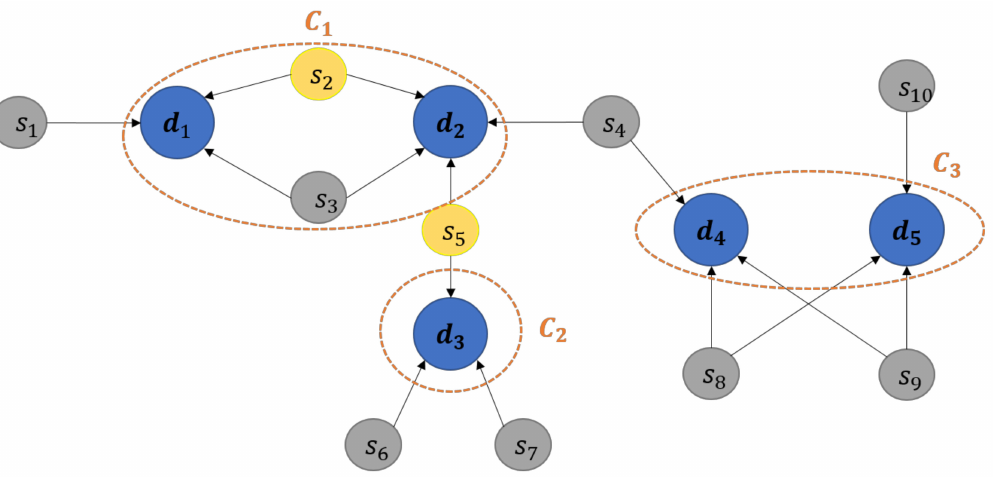
Figure 3. The toy problem KG, including the communities and evidence symptoms (yellow